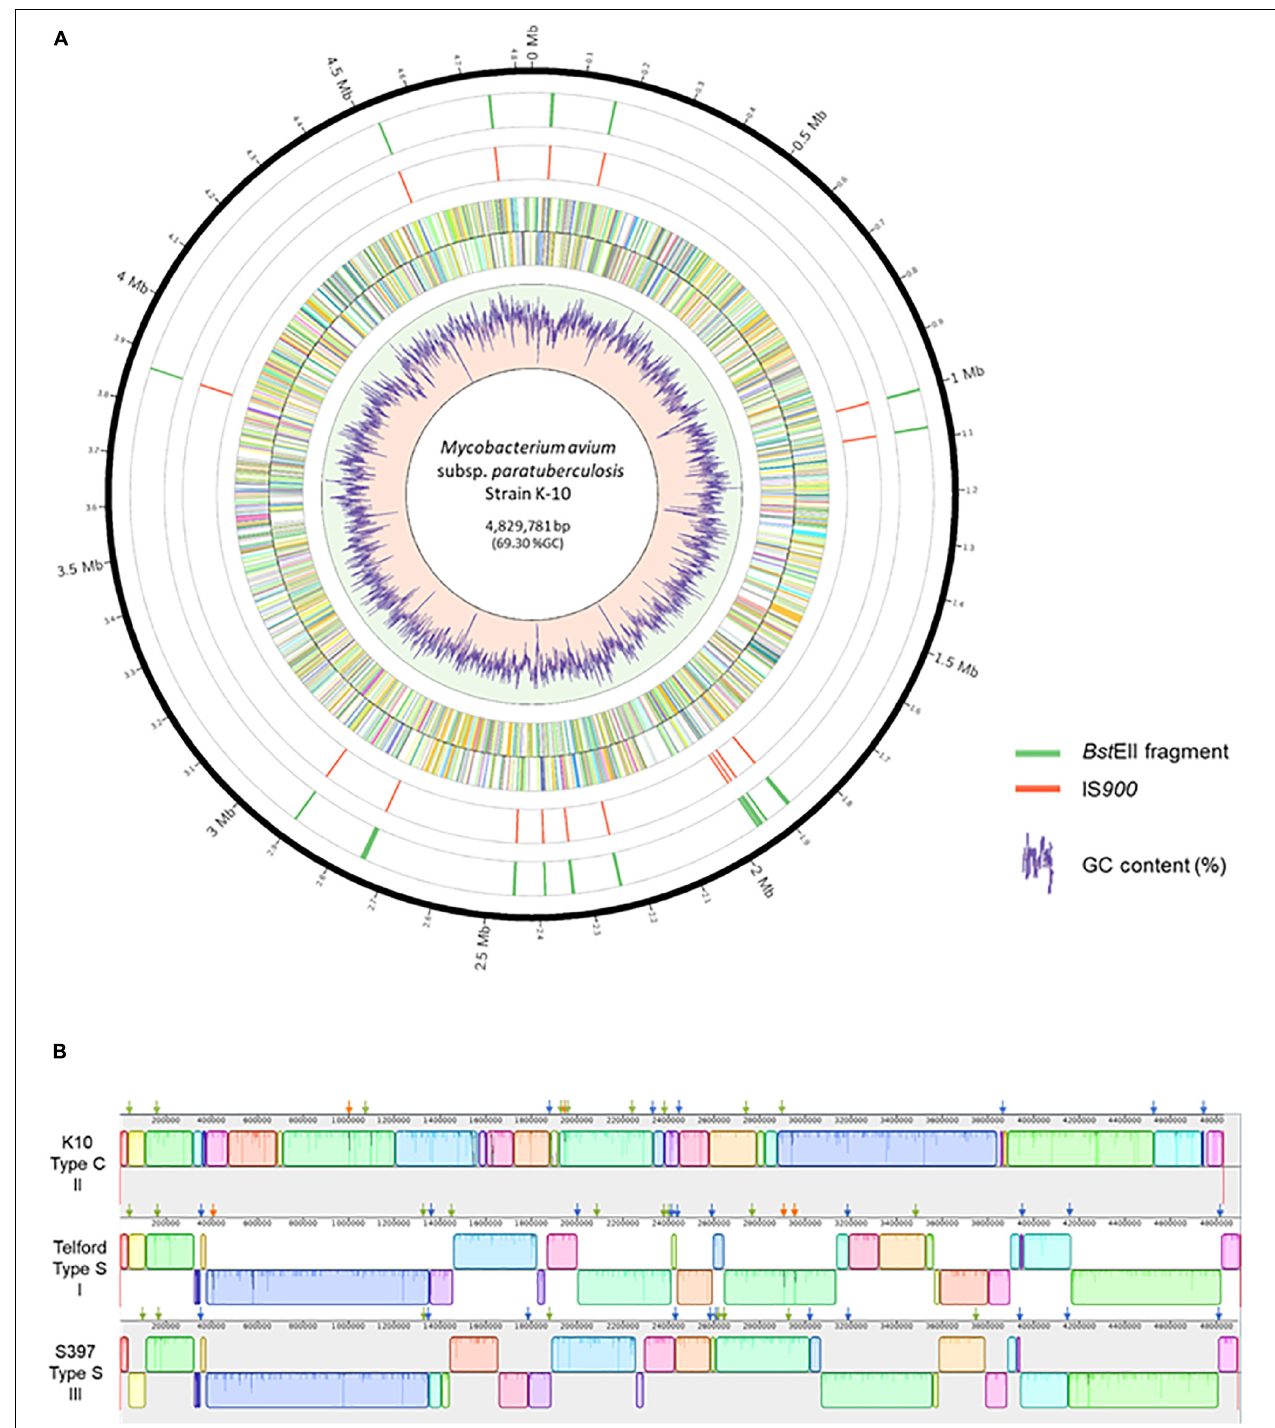
FIGURE 2 | Distribution of IS 900 copies on the genome of Mycobacterium avium subsp. paratuberculosis strain K-10. (A) Shown, using Circos version 0.69–8, from the outer circle to the inner circle are the megabase (Mb) positions on the chromosome, the Bst EII restriction sites, the position of each IS 900 element, plus strand ORFs, minus strand ORFs and a plot of the percent GC. (B) Mauve alignment of K-10 (top) with Telford (middle) and S397 (bottom) showing genomic reorganization of the genomes. The colored boxes represent homologous regions present in each genome. Blocks below the centerline indicate regions with inverse orientation. Regions outside the blocks lack homology between the genomes. Within each block there is a similarity profile of the DNA sequences and the white areas indicate sequences specific to a genome. The scale is in base pairs. Orthologous insertions are indicated, using the slider of Mauve, by a green arrow, specific insertions are indicated by a orange arrow and conserved loci only in two genomes by a blue